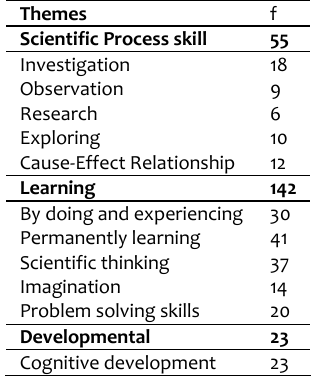
Table 1. The views of preschool teachers on importance of the science and mathematics